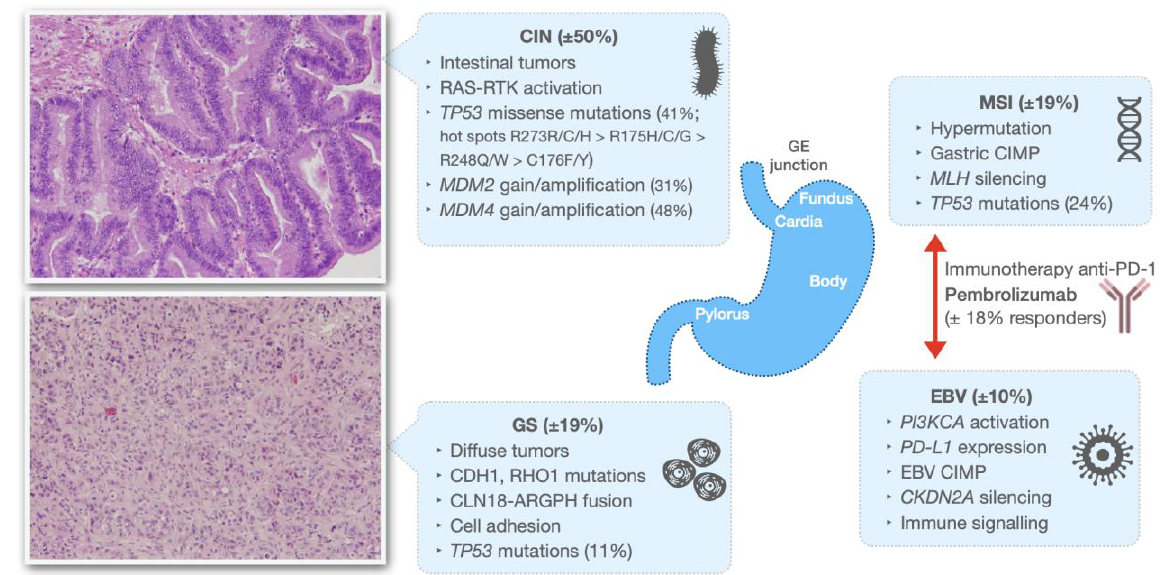
Figure 1. Histological and molecular subgroups of gastric cancer. Gastric cancer has two major histological subtypes: the intestinal subtype (upper left) that presents differentiated cancer cell structures in glands, and the diffuse subtype (lower left) that displays undifferentiated cancer cells dispersed within the stroma. There are also four molecular subgroups defined by the TCGA: the Chromosome instable (CIN), the Genetic Stable (GS), the Microsatellites Instable (MSI), and the Epstein–Barr Virus (EBV) subgroups. Each are characterized by specific deregulated mechanisms. Of note is the two molecular subgroups that tend to respond the best to immunotherapy, the MSI and the EBV subgroups.